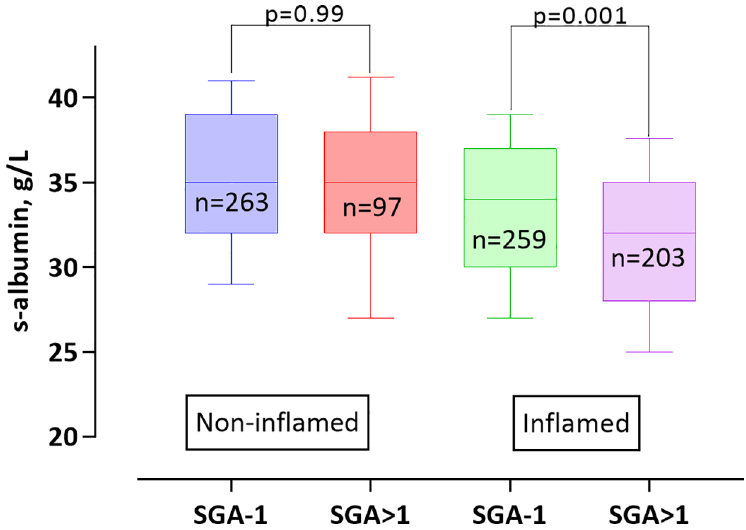
Fig 1. Association between S- albumin and subjective global assessment score (SGA) in 822 CKD stage 5 patients, according to inflammatory status. Inflamed and non-inflamed were definedaccordingto hsCRP concentrations aboveor below3